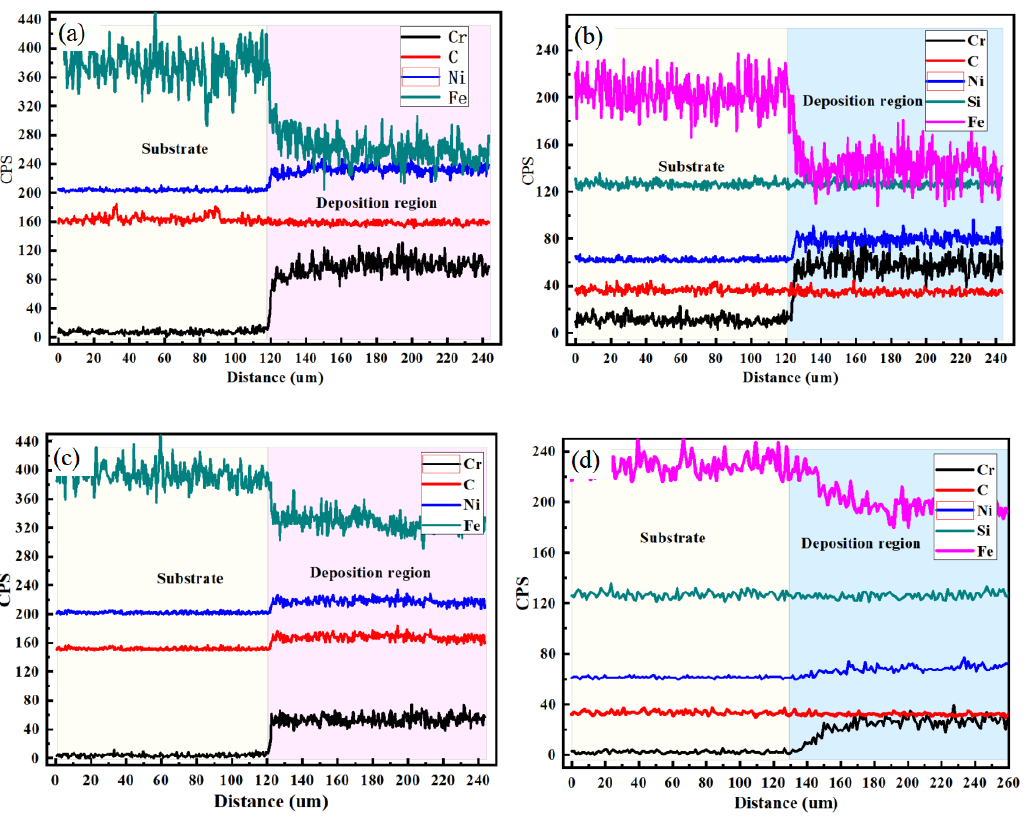
Figure 8. Line scanning analysis from substrate to deposition material without substrate preheating: ( a ) 1045 to 316 L; ( b ) P20 to 316 L; ( c ) 1045 to 316 L under preheating; ( d ) P20 to 316 L under preheating.